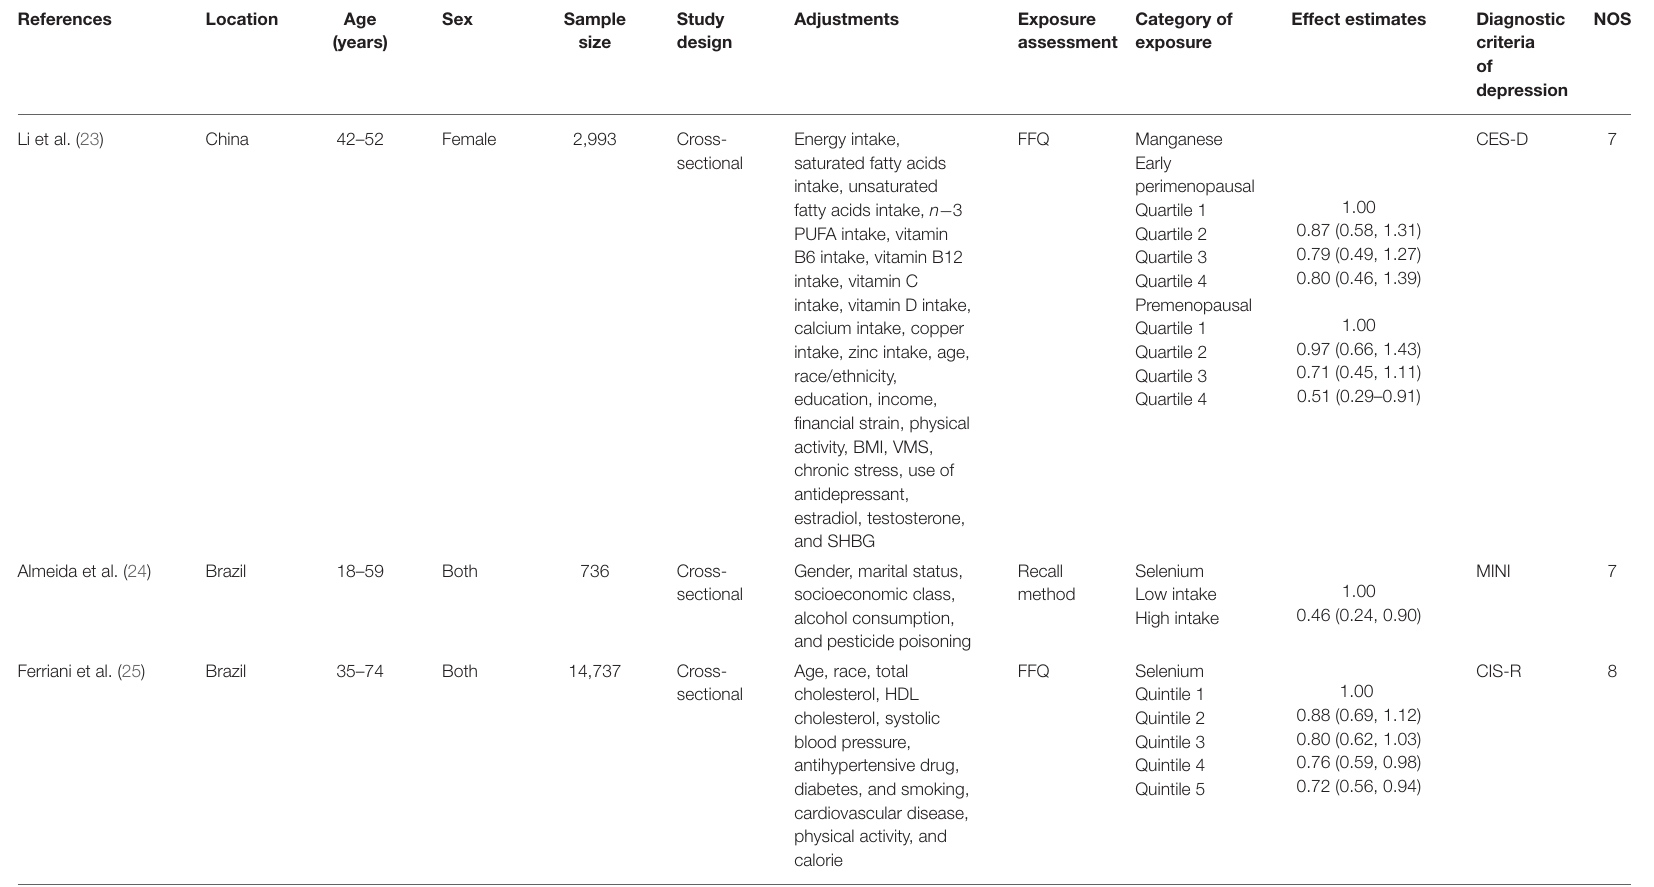
BMI, Body mass index; FFQ, Food frequency questionnaire; CVD, Cardiovascular disease; HDL, High density lipoprotein; HTA, Hypertension; T2DM, Type 2 diabetes mellitus; PUFA, Polyunsaturated fatty acid; VMS, Vasomotor symptoms; SHBG, Sex hormone binding globulin; DSM-IV, Diagnostic and Statistical Manual of Mental Disorders-IV; PHQ-9, Patient Health Questionnaire-9; CES-D, Center for Epidemiological Studies Depression Scale; BDI, Beck Depression Inventory; K6, Kessler’s six-item psychological distress scale; GDS, Geriatric Depression Scale; MINI, Mini-International Neuropsychiatric Interview; CIS-R, Clinical Interview Schedule